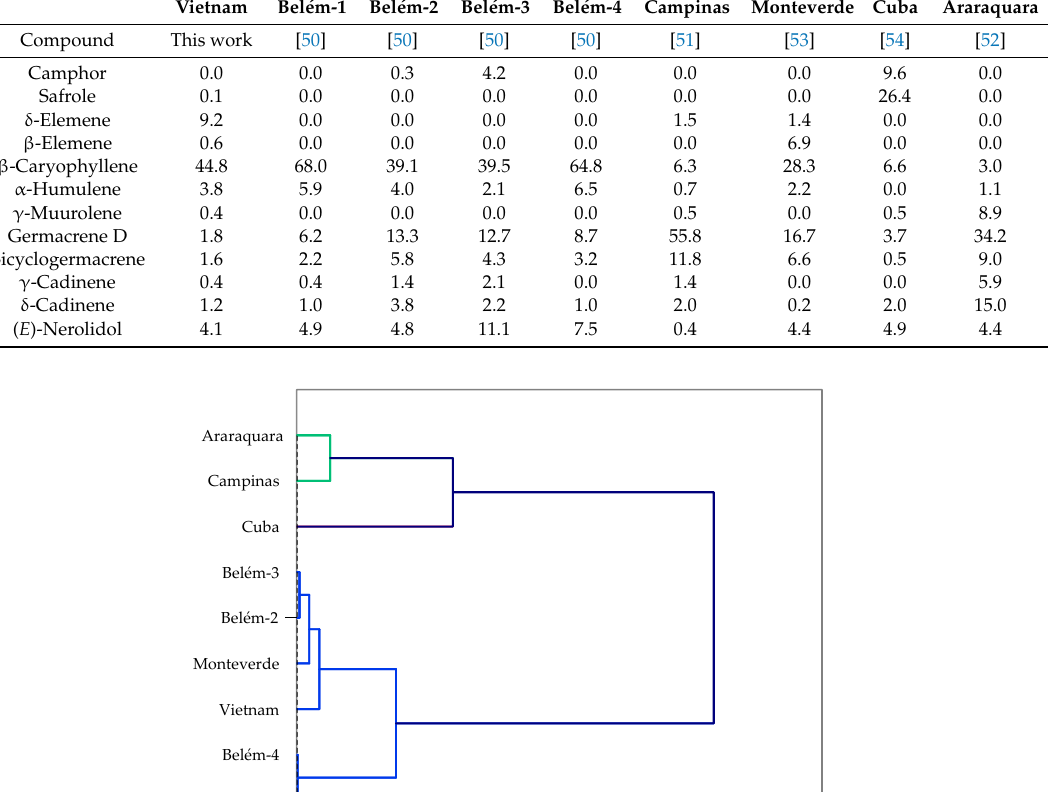
Table 3. Major essential oil components (%) of Piper umbellatum .